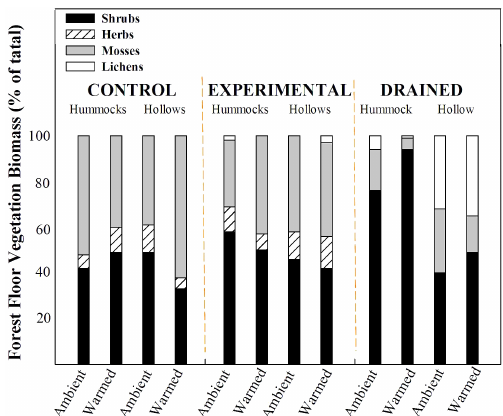
Figure 3. Relationship between drainage, warming and microform scenario and ground-layer above-ground biomass by category as a percentage of the